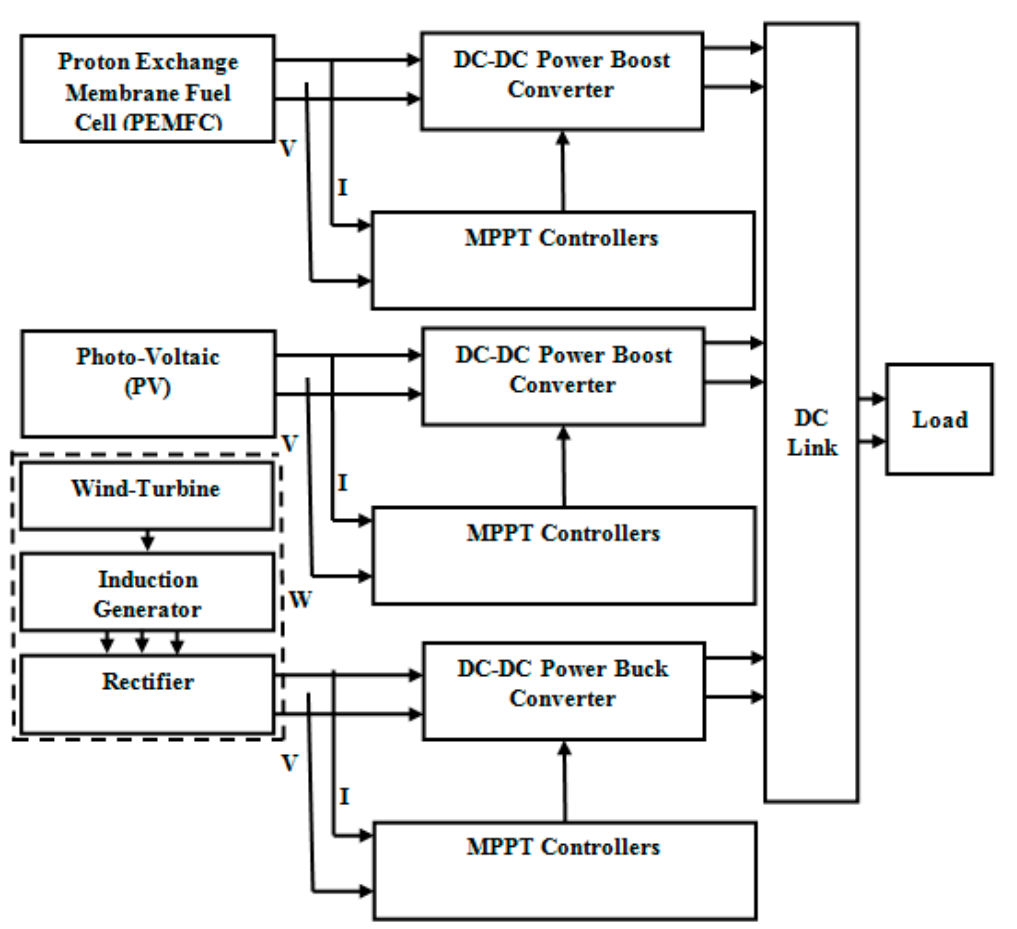
Figure 5. Proposed combination of FC–PV–W systems with different MPPT controllers.